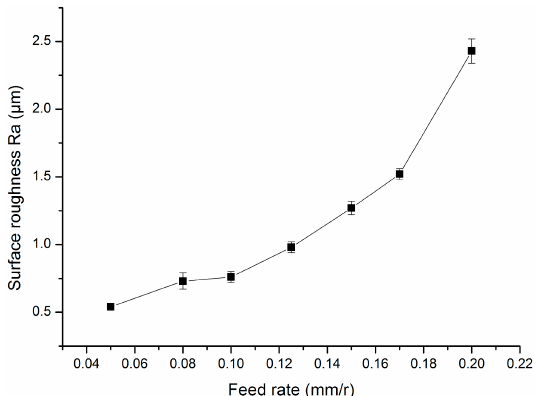
Figure 19. Evolution of surface roughness against cutting time at different feed rates (cutting speed of 50 m/min, depth of cut of 1.0 mm).